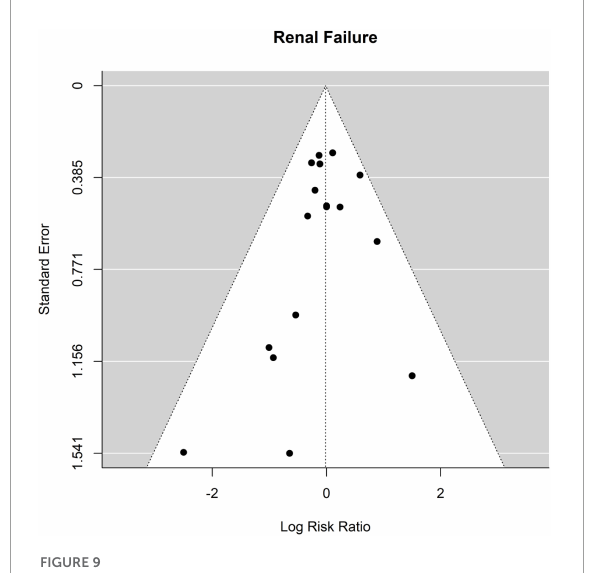
FIGURE9 Relative risk of renal failure (RF) in patients undergoing aortic interventions with conventional elephant trunk (ET) vs. frozen elephant trunk (FET). Funnel plot.